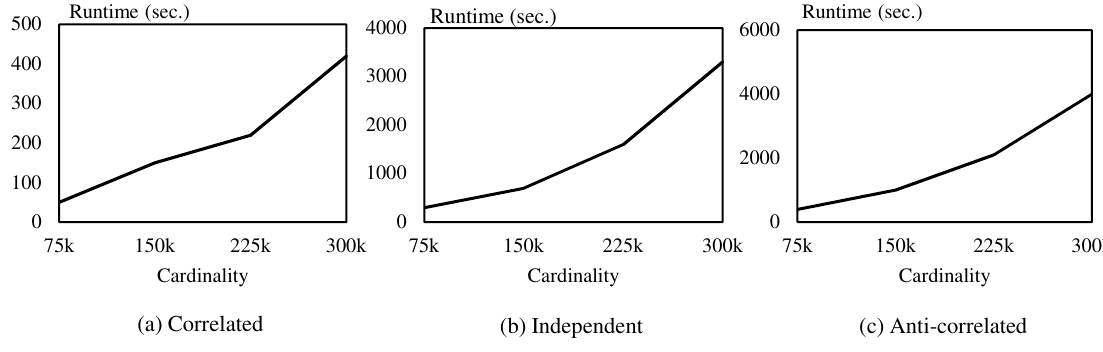
Figure 9. Performances for different cardinalities.